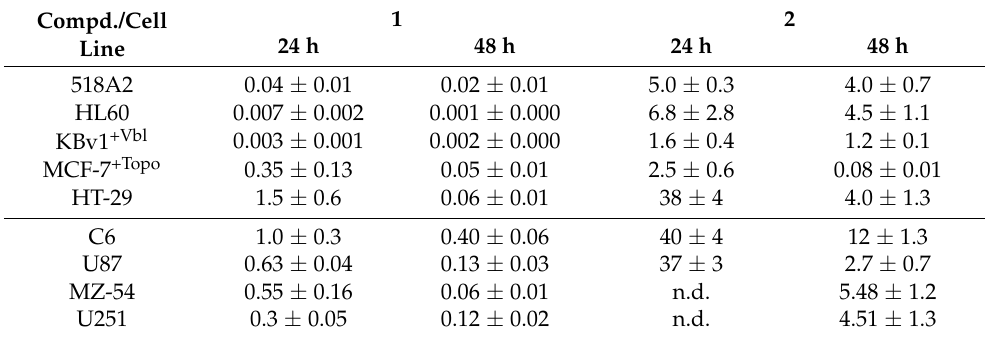
Table 1. Inhibitory concentrations IC 50 ( µ M) 1 of 1 and 2 in cancer cells including several GBM cells. Compd./Cell